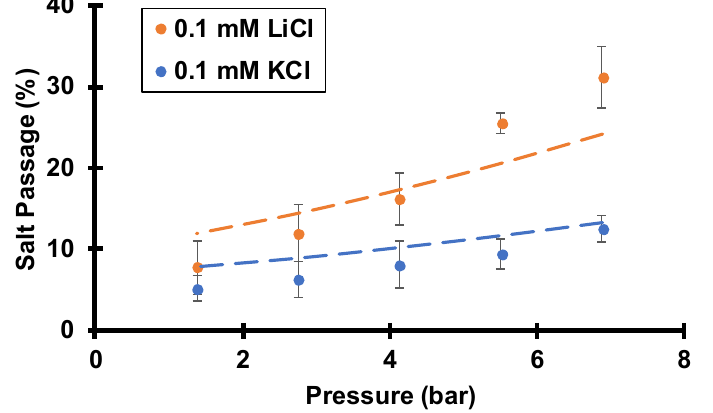
Figure 7. Salt passages during flow of 0.1 mM KCl or 0.1 mM LiCl through track-etched membranes (30 nm pores) using various transmembrane pressures while rotating the membrane at 1000 rpm. Dashed lines are simulated passages assuming a surface charge density of − 2.2 mC/m 2 , a pore diameter of 30 nm, and a boundary layer thickness of 19.4 µm, as estimated from the Levich equation.